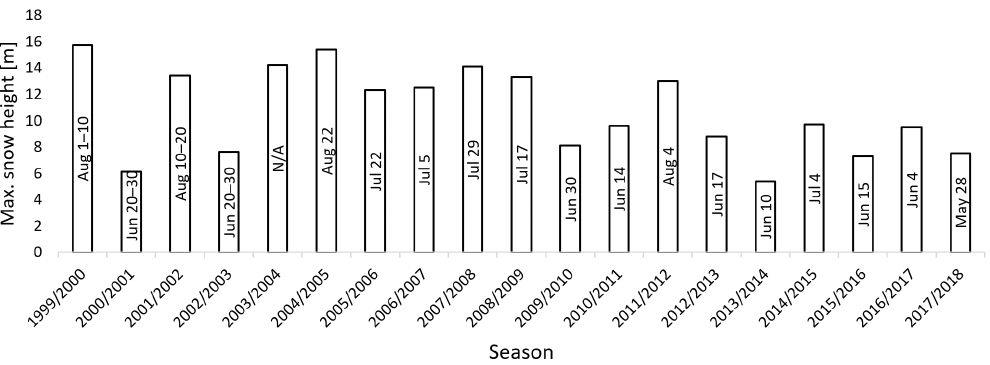
Figure 3. The data on the maximum snow height and melting days since 1999 (the year when the global positioning system (GPS)-based monitoring was performed for the first time).